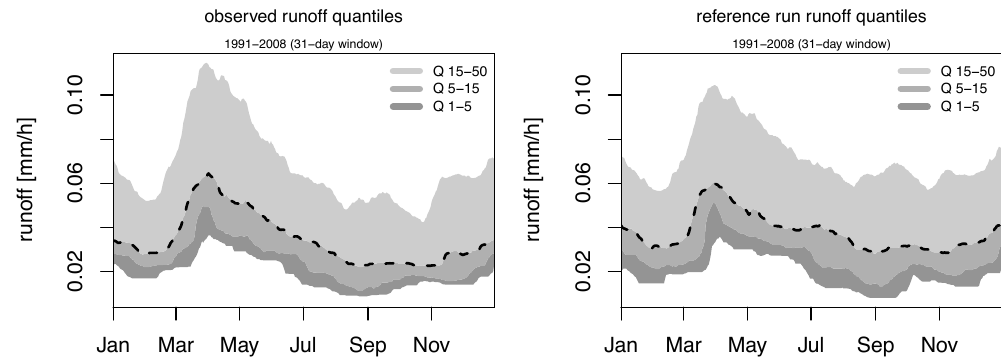
Fig. 2. Lower runoff quantiles for the Thur catchment from gauge measurements (left) and the hydrological reference run (right). The quantiles were calculated for daily mean runoff and non-exceedance probabilities of 1%, 5%, 15% (dashed line) and 50%, utilizing a window of 31 days around the day of interest.